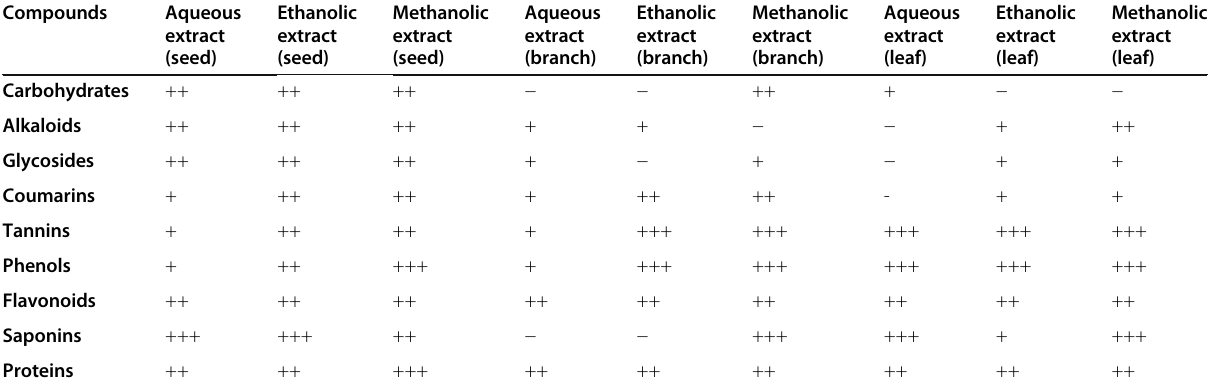
Table 1 Preliminary phytochemical screening of different extracts of B. orellana Compounds